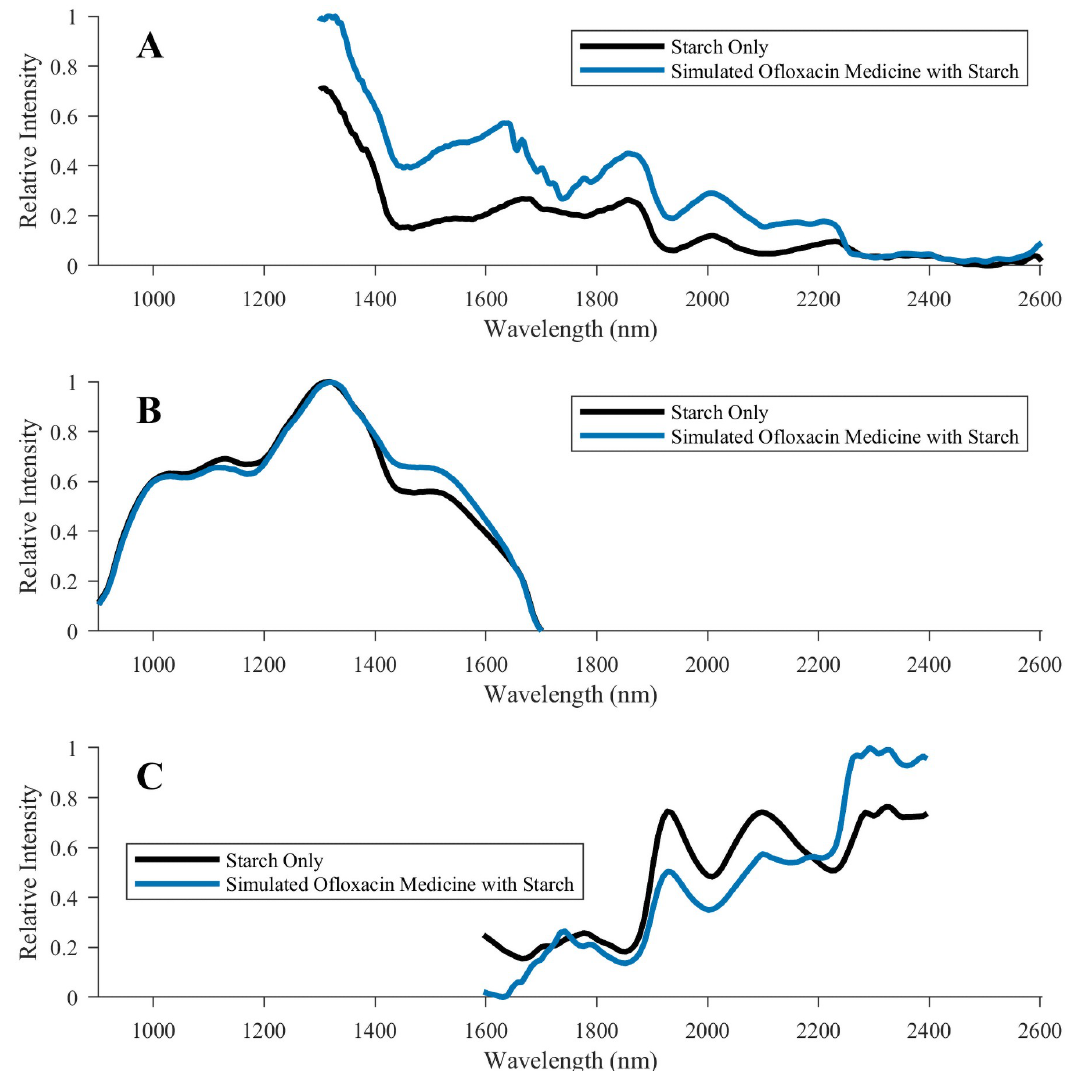
Fig 2. Comparison of NIR spectra obtained for ofloxacin-containing simulated medicines. Spectra were collected for ofloxacin- containing simulated medicines using the (A) Neospectra 2.5, (B) NIR-S-G1, and (C) MicroPHAZIR RX spectrometers. The black trace is of a falsified simulated medicine tablet containing only starch. The blue trace is of a simulated good quality ofloxacin sample that contained starch as the bulk